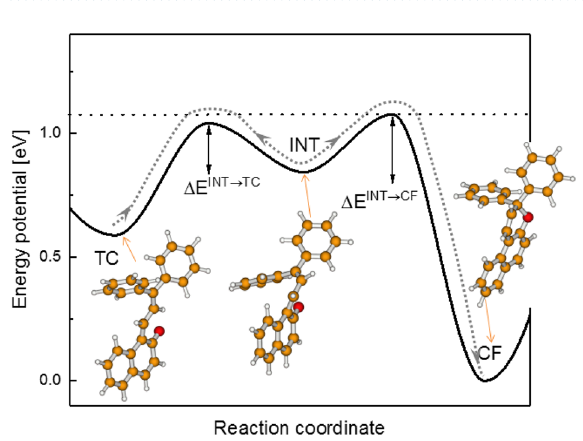
Figure 1. UV excitation of 3,3-diphenyl-3 H -naphtho[2,1- b ]pyran ( 1 ) converts the closed form CF to color isomers TC (short-lived) and TT (long-lived), with the intermediacy of cisoid-cis form INT (ultrashort-lived) 11 . Compound 2 with a methoxy group implemented at one of the phenyl rings at ortho position is selected for studies of a strong photocoloration effect.